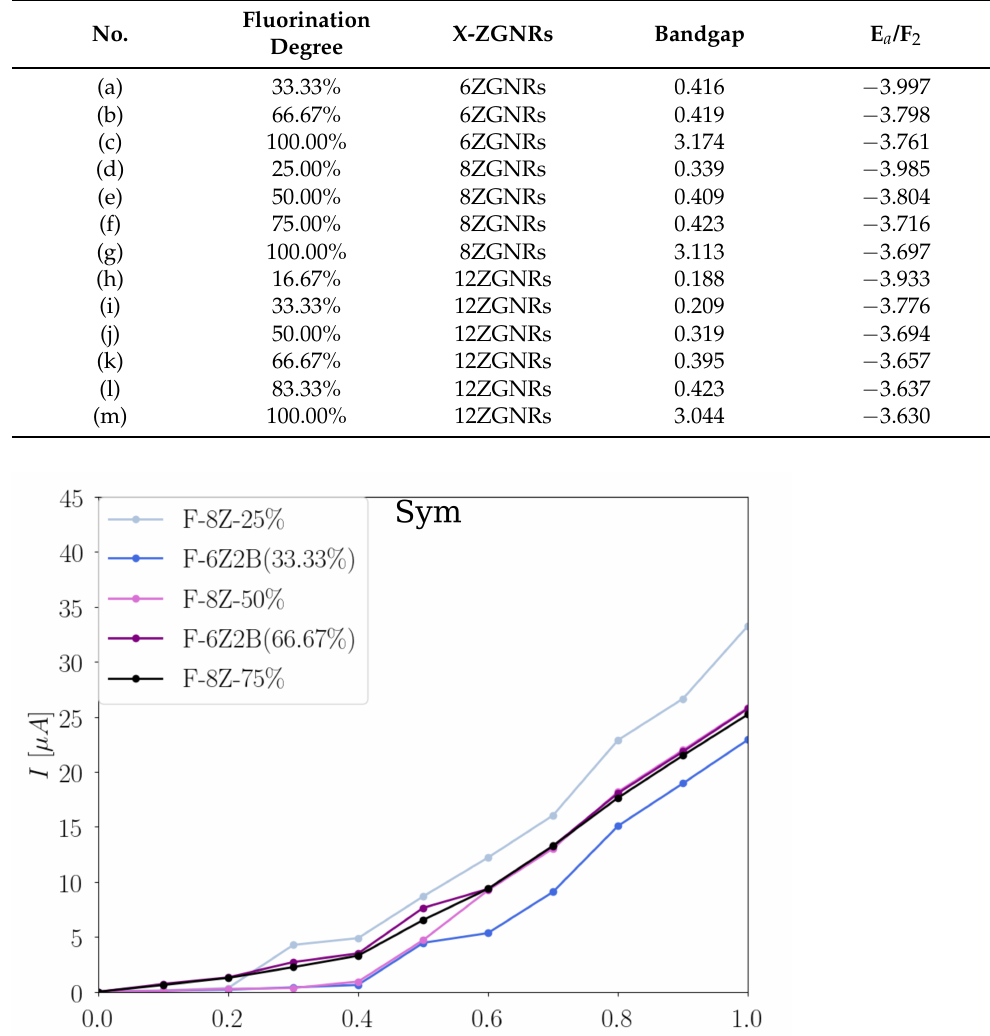
Table 2. Bandgaps for both α and β channels, and the average binding energy per F 2 for the most thermodynamically stable structures at each considered fluorination degree. It is noted that the bandgap of two spin channels are degenerate. All energy values are given in eV and they are obtained at the PBE level.